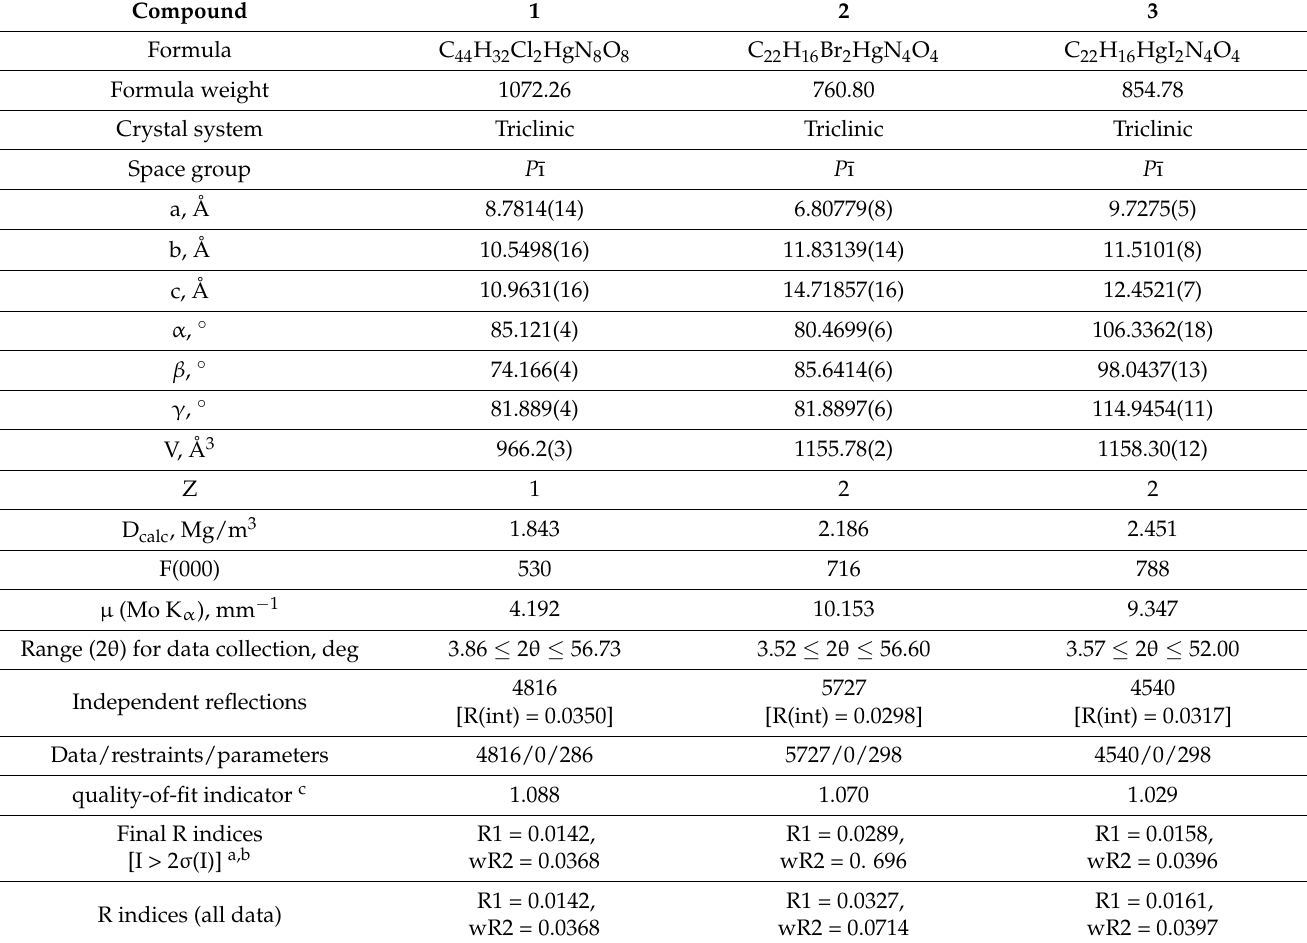
Table 6. Crystallographic data for 1 – 9